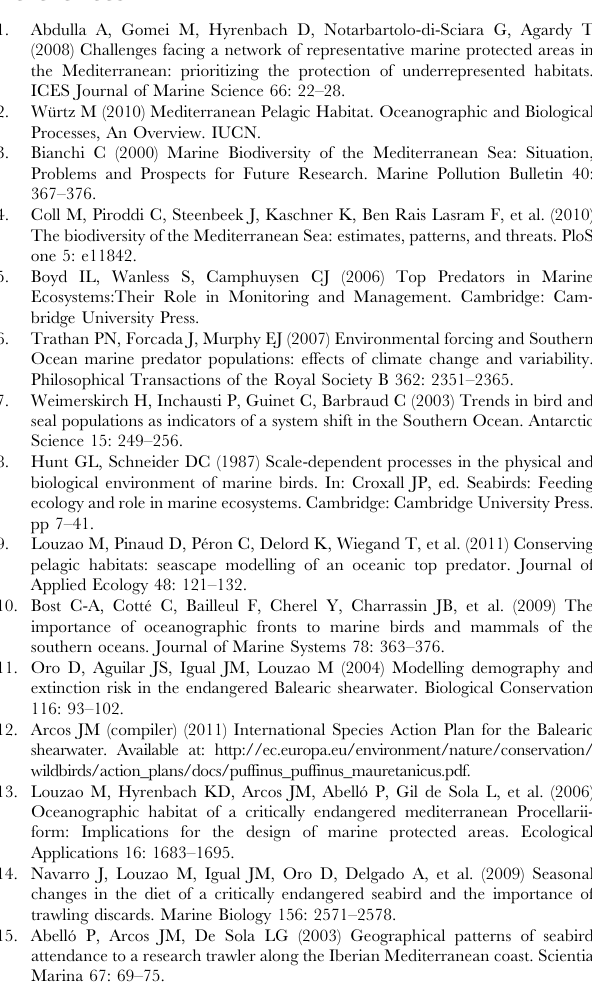
Figure S1 Biogeographic area visited by each breeding shearwater. Figure S2 Examples of a Balearic shearwater commut- ing. Figure S3 Time series of small pelagic fish captures in the western